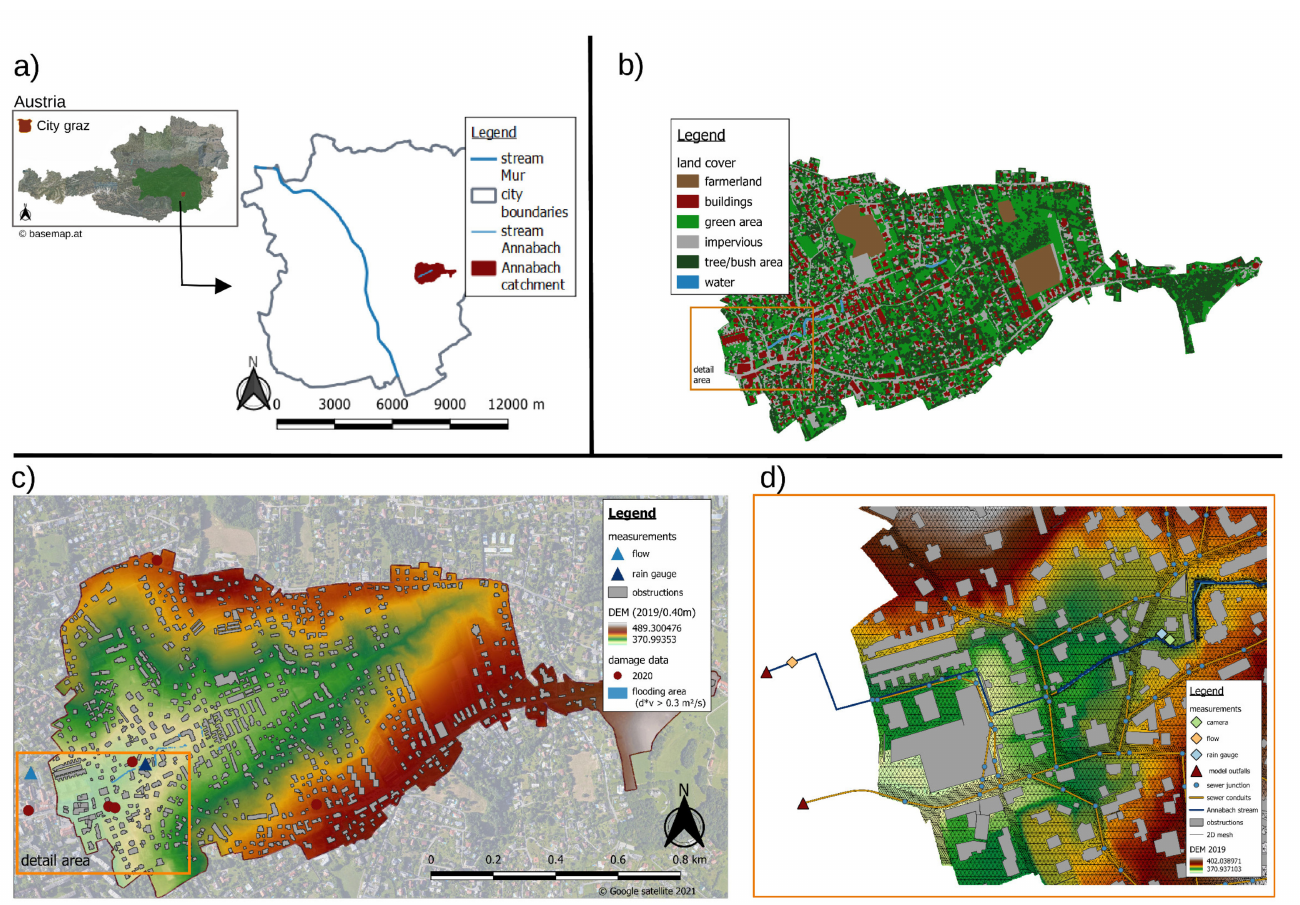
Figure 2. The location of the Annabach catchment inside the City Graz in Austria ( a ), the land cover distribution in the Annabach catchment ( b ), the locations of the measurement systems ( c ) and the recorded damage data in Annabach catchment ( d